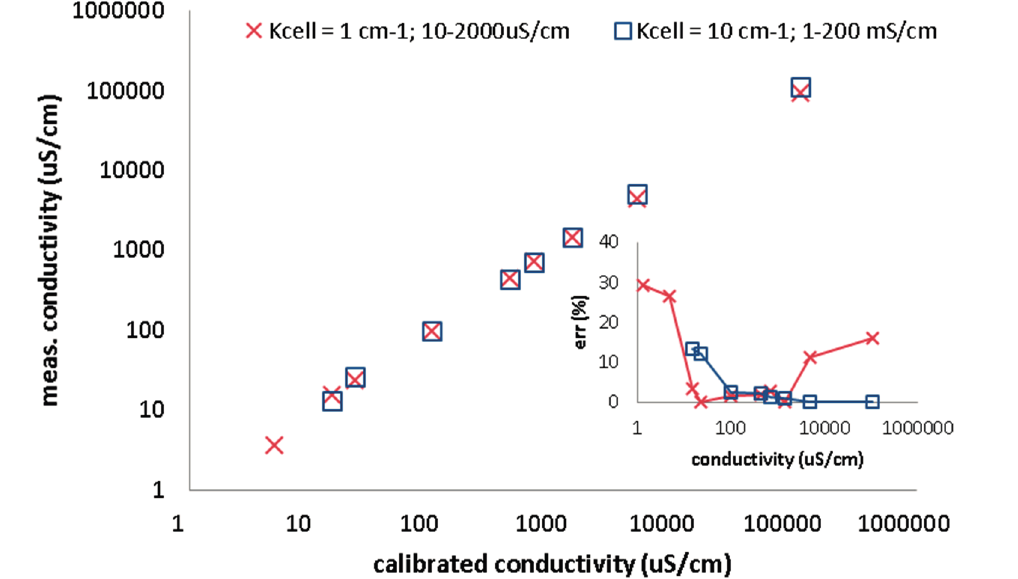
Figure 2. Conductivity measurements with CyberScan PC6500. Two electrodes with cell constant 1 and 10 cm -1 calibrated at two points. Measured conductivity versus calibrated samples are plotted. Inset of figure presets relative error of measured conductivity. The error is high out of the cell conductivity range.